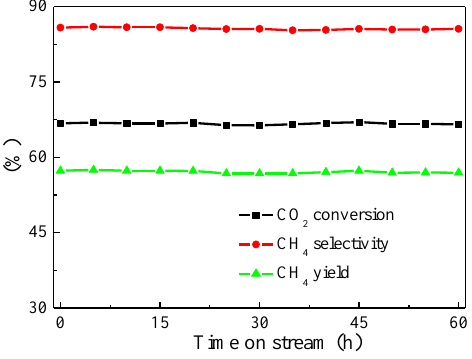
Figure 8. Catalytic stability test of 20Ni-0.5V / KIT-6.